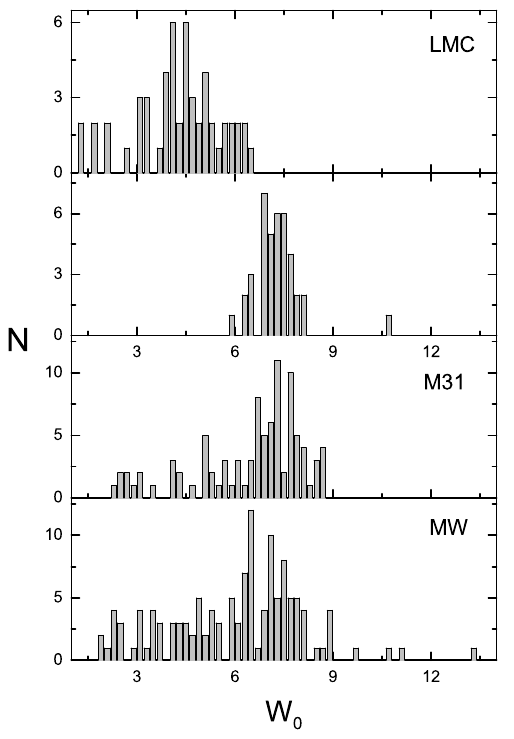
Figure 11: Comparison among W 0 distributions of different GCs systems. In addition to MW system, M31, NGC5128 and LMC systems are reported. M31 data come (or are deduced) from Barmby et al. (2007), NGC5128 ones from G`omez et al. (2005), LMC data from Mackey & Gilmore (2003a). MW histogram differ- ences from Fig.2 are given by a different binning